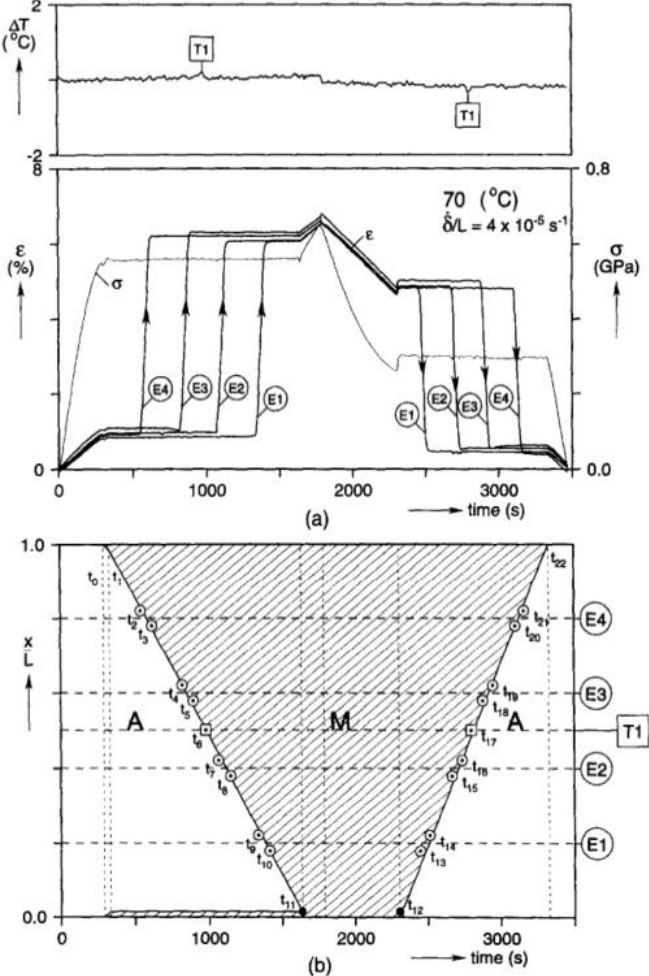
Figure 4. ( a ) Temperature, stress, and strain histories at four sensor positions under a strain rate of 4 × 10 − 5 s − 1 ; ( b ) Location-time diagram of significant events [11]. (Reprinted from Ref. [11], Figure 11, 1995, with permission from Elsevier.)